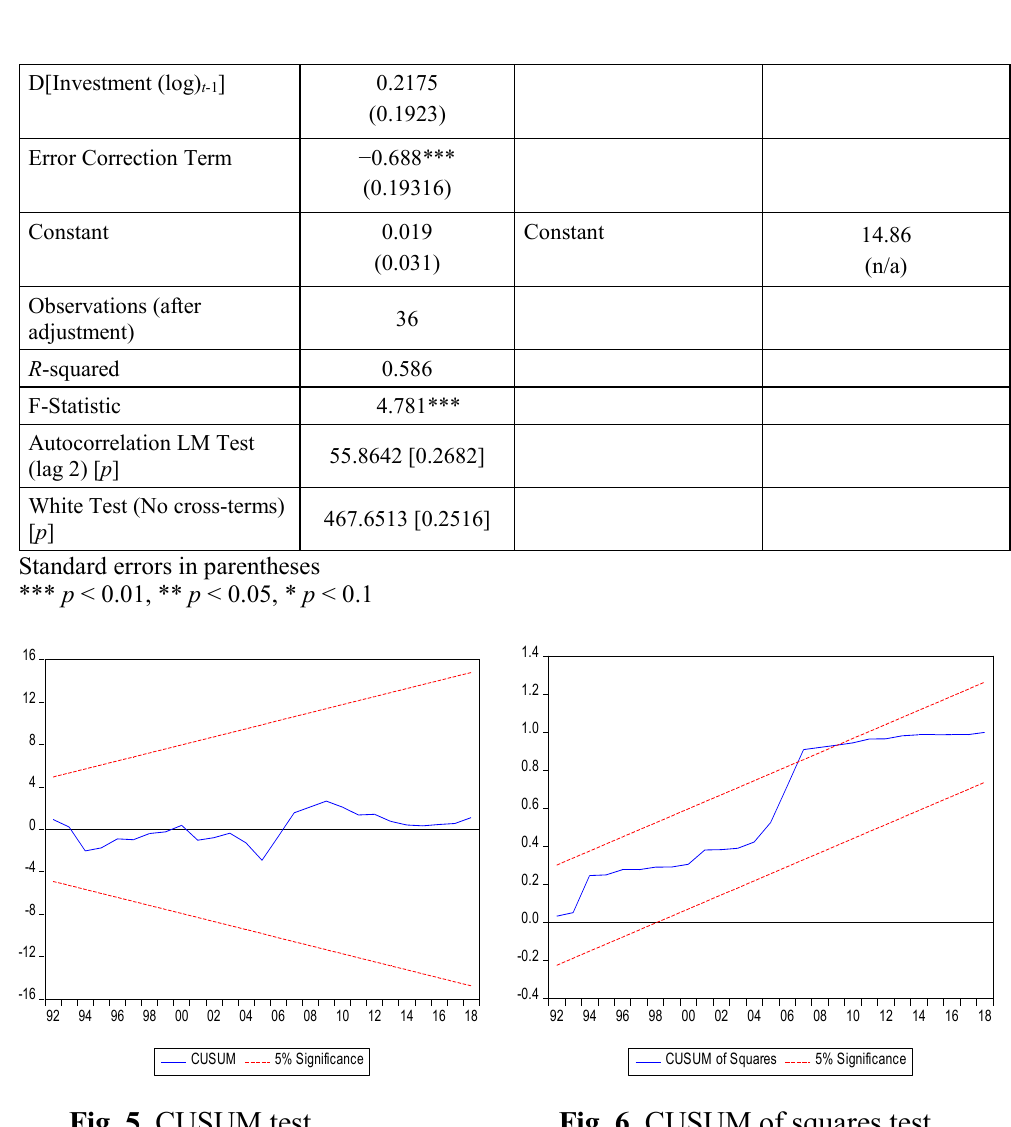
Fig. 5. CUSUM test. Fig. 6. CUSUM of squares